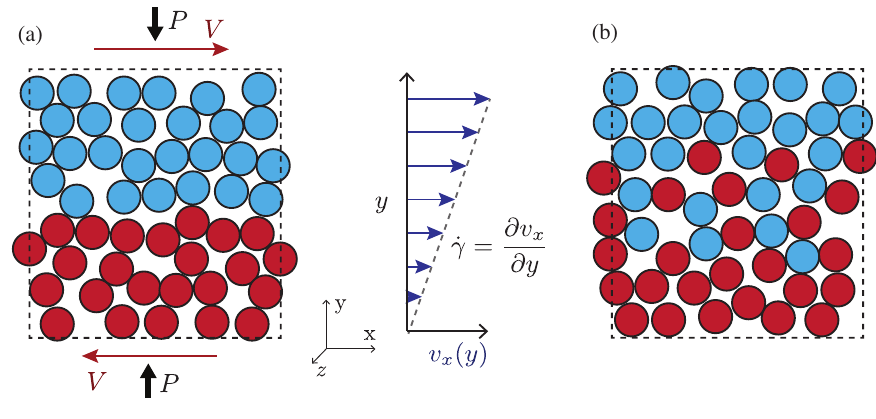
Figure 1. Illustration of mixing resulting from shear-induced di ff usion. An assembly of grains is sheared in the x -direction by applying opposite velocities V at the top and bottom and a normal stress P . (a) Initially, grains located in the bottom half of the shear cell are coloured in red and those in the top-half in blue; grains keep their colour during the flow. (b) After some shear deformation, a mixing zone develops in the centre of the cell. The DEM simulations presented in the paper simulate this configuration: plane shear flow prescribing the normal stress P and the shear rate ˙ γ , using periodic boundary conditions (represented with the dashed line). This configuration leads to a homogenous shear state characterised by the linear velocity profile represented here, where v x ( y ) is the average velocity of the grains located at the height y